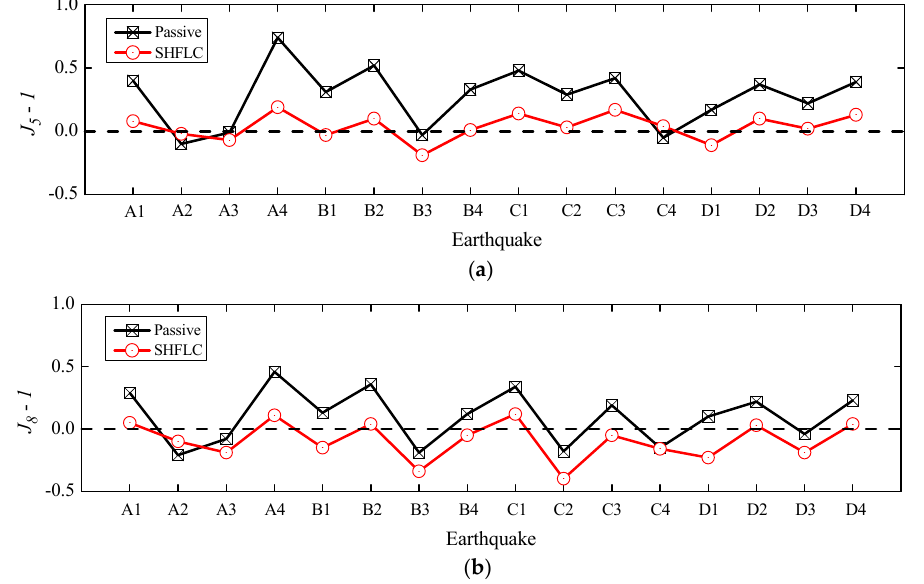
Figure 11. Performance indices J 5 and J 8 for different control cases under various types of earthquakes: ( a ) Performance index J 5 ; and ( b ) Performance index J 8